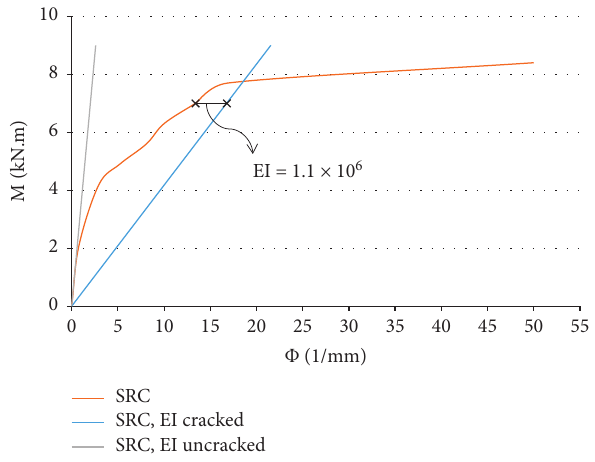
Figure 9: Tension stiffening of SRC beams.